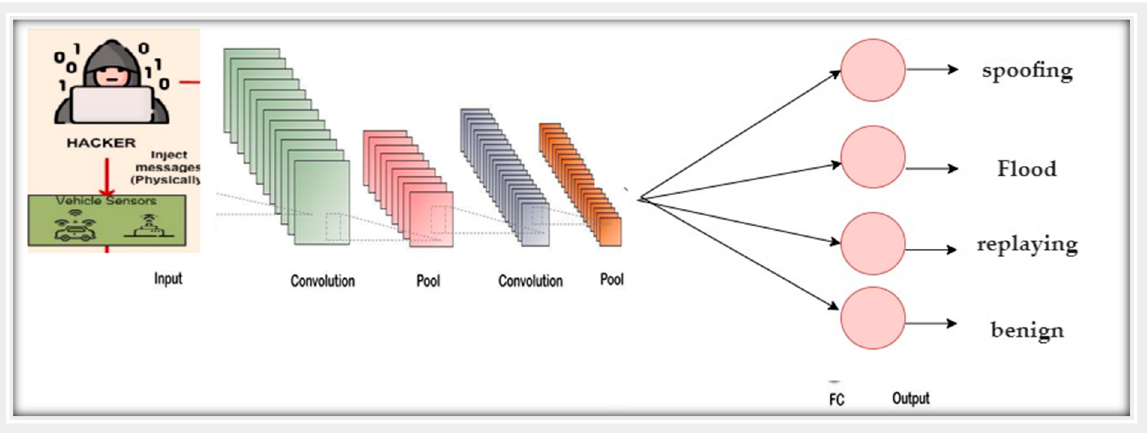
Figure 6. The structure of the CNN model.